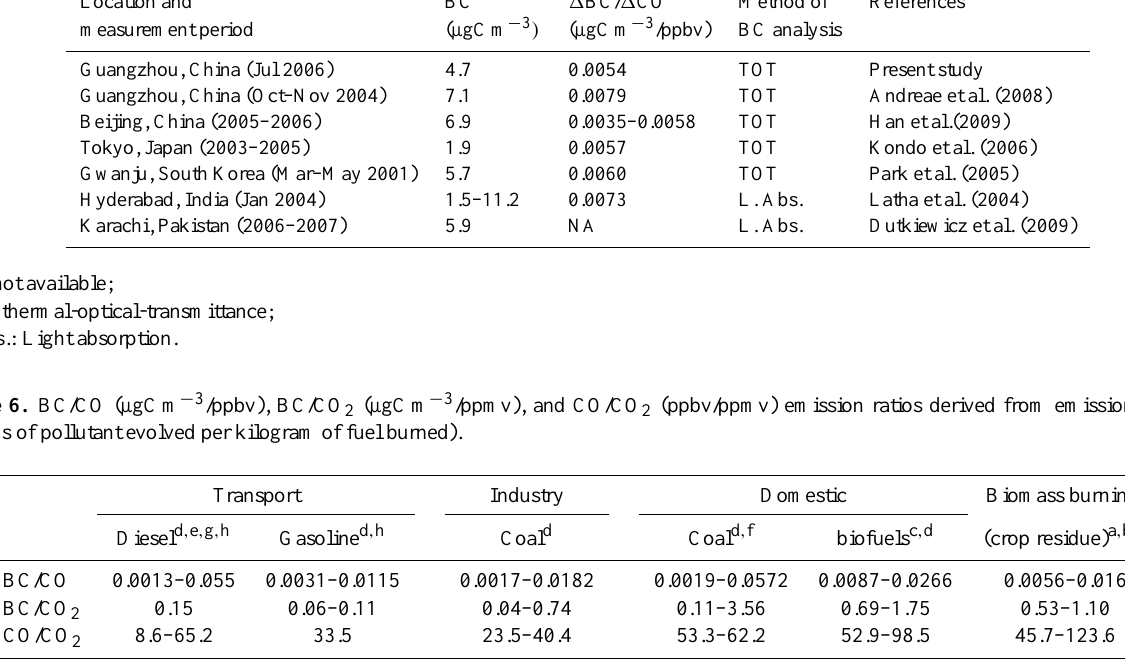
Table 5. Concentrations of BC aerosol and linear fit regression slopes measured in major urban regions of Asia. Location and